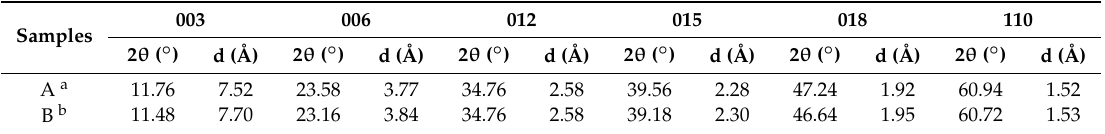
Table 1. XRD data of Mg/Al LDH and FDTS-Mg/Al LDH.